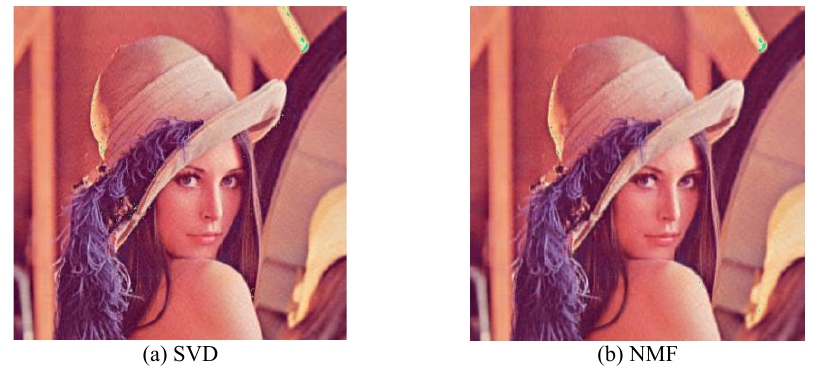
Fig. 2. Compressed images with rank 80.